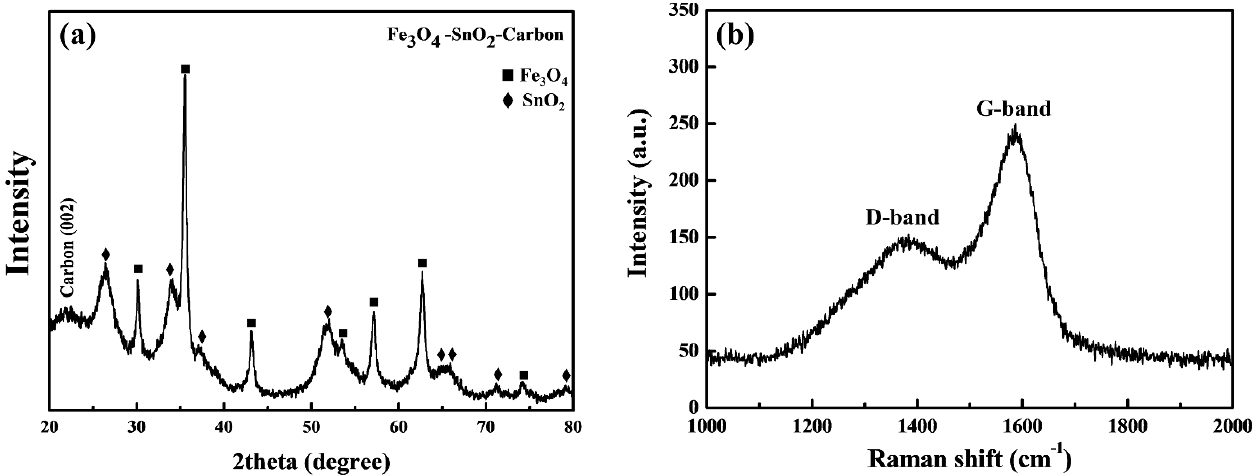
Figure 8. XRD patterns ( a ) and Raman spectra ( b ) of the Fe 3 O 4 -SnO 2 -C composite nanoparticles.